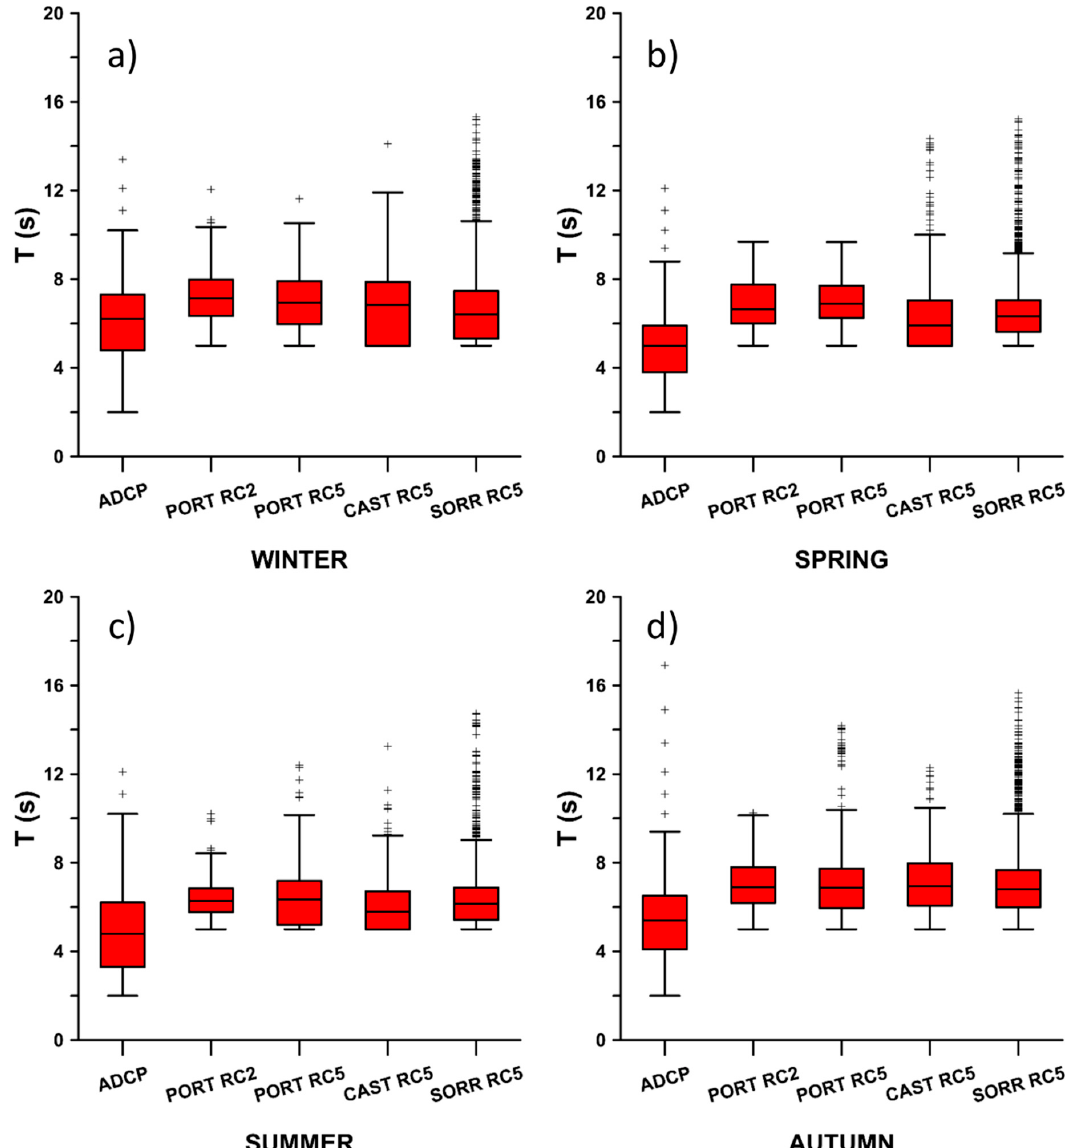
Figure 5. Cumulative seasonal T boxplots recorded by the ADCP and the HF radars. For the PORT site, both RC2 and RC5 data are shown. The panels show the different seasons: ( a ) winter; ( b ) spring; ( c ) summer; and ( d ) autumn. Table 3. Joint frequency distributions of the wave measurements (Hs and θ ) recorded by the ADCP and the HF radars. Data were grouped in eight Hs classes of 0.50 m each, and in direction sectors with an angle of 15°. For each combination of Hs and θ values, the number of occurrences was calculated.